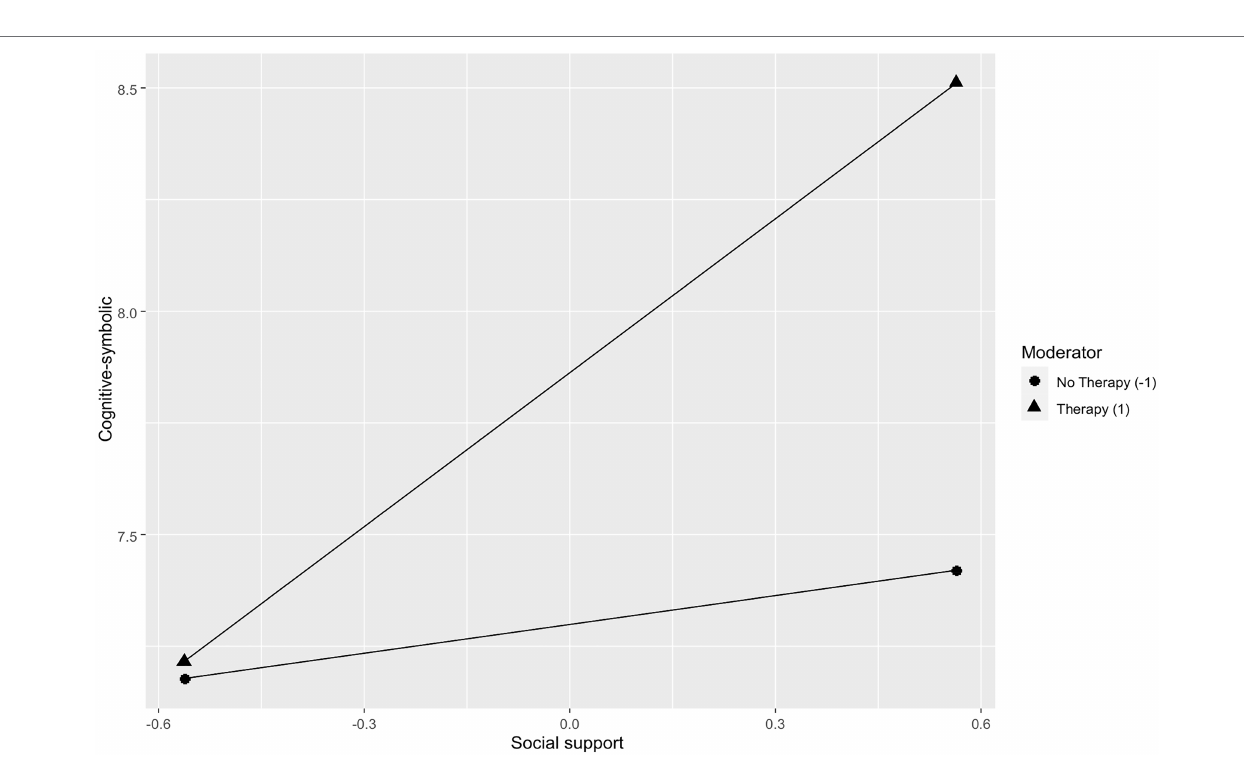
FIGURE 2 | Simple slope showing the role of psychotherapy as moderator in the relationship between cognitive-symbolic and social